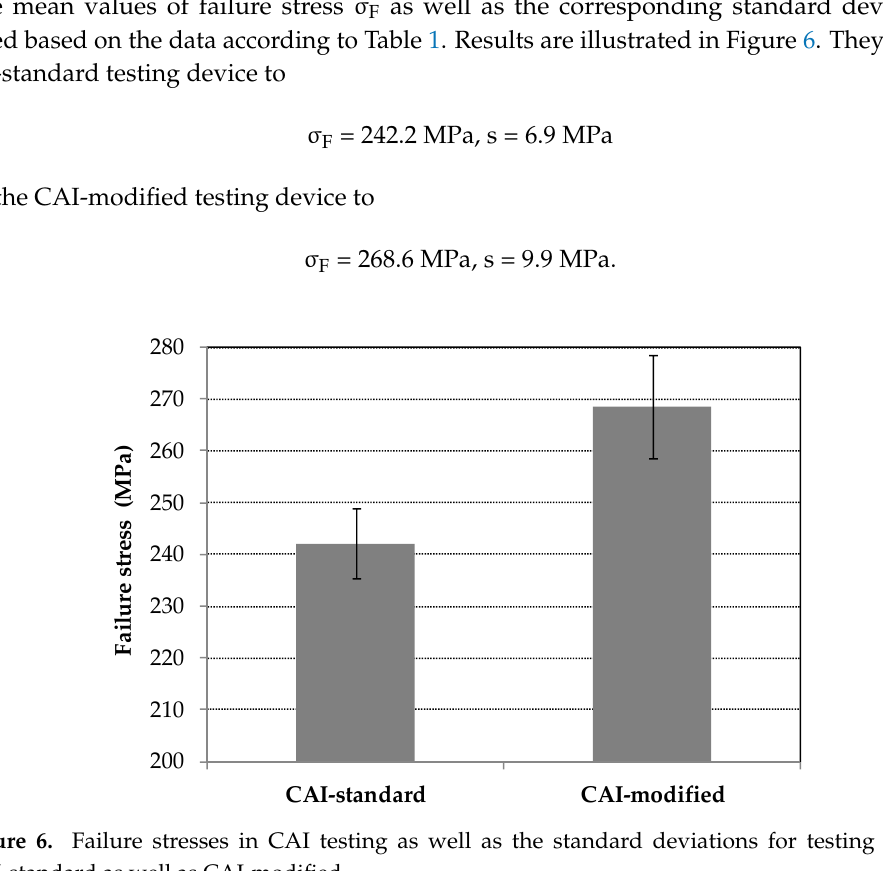
Figure 5. Illustrative kink zone and fracture, specimen P2-S10.